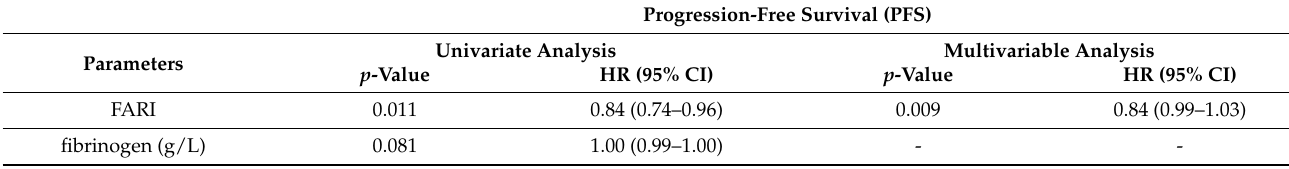
Table 2. Results of univariate and multivariable Cox regression model with respect to PFS on DSS. Multivariable models were fitted applying a stepwise hierarchical selection approach at a significance level p < 0.05. As younger age at therapy was associated with higher recurrence rates in descriptive statistics, the variable was included into multivariable analysis to rule out gross confound- ing.